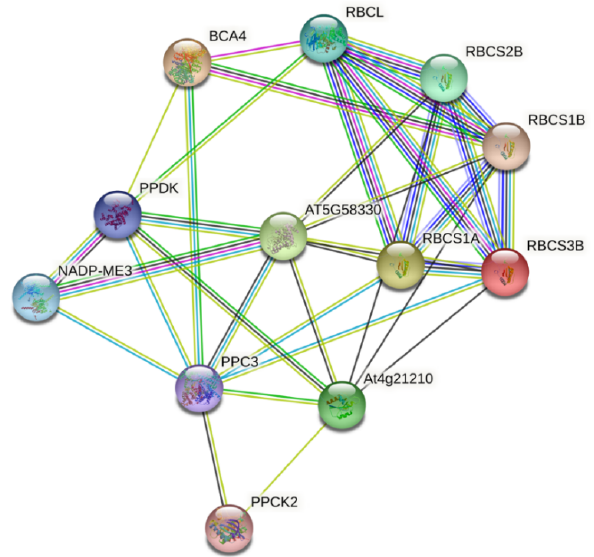
Figure 6. Protein–protein interaction prediction between selected C4 type of carbon delivery chain candidates in Arabidopsis thaliana . Each dot represents an enzyme. The lines between each dot represent the levels and confidence of the prediction. Among them, AT5G58330 is NADP-MDH and At4g21210 is PPDK-RP1.